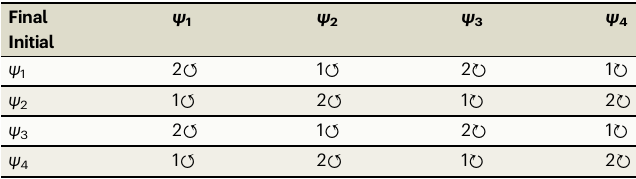
Table 1 | Programmable four-mode switch, a summary of Fig.